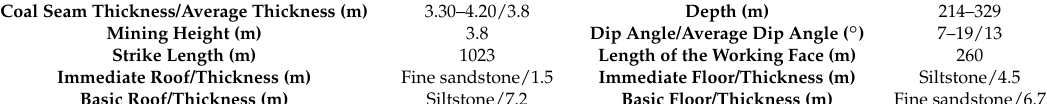
Table 3. Basic parameters of the 011810 working face in the Jinfeng Coal Mine.